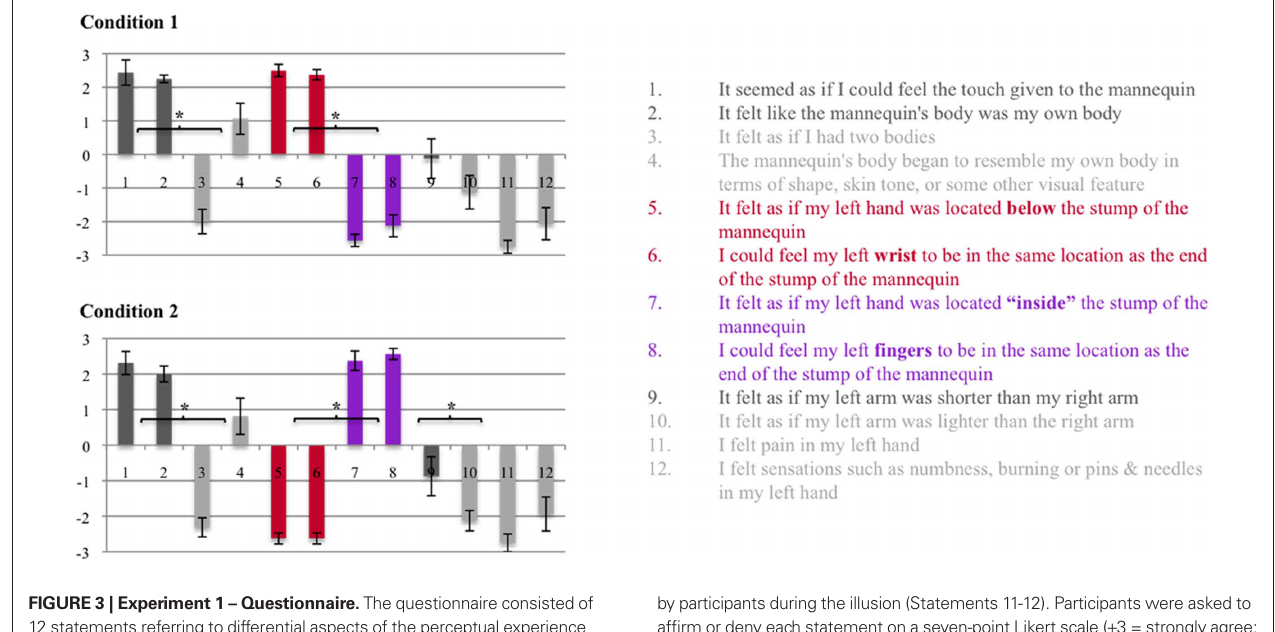
Figure 3 | experiment 1 – Questionnaire. The questionnaire consisted of 12 statements referring to differential aspects of the perceptual experience induced by the stroking sessions: Experience of the full-body illusion (Statements 1–4); Perceived location of the left hand (Statements